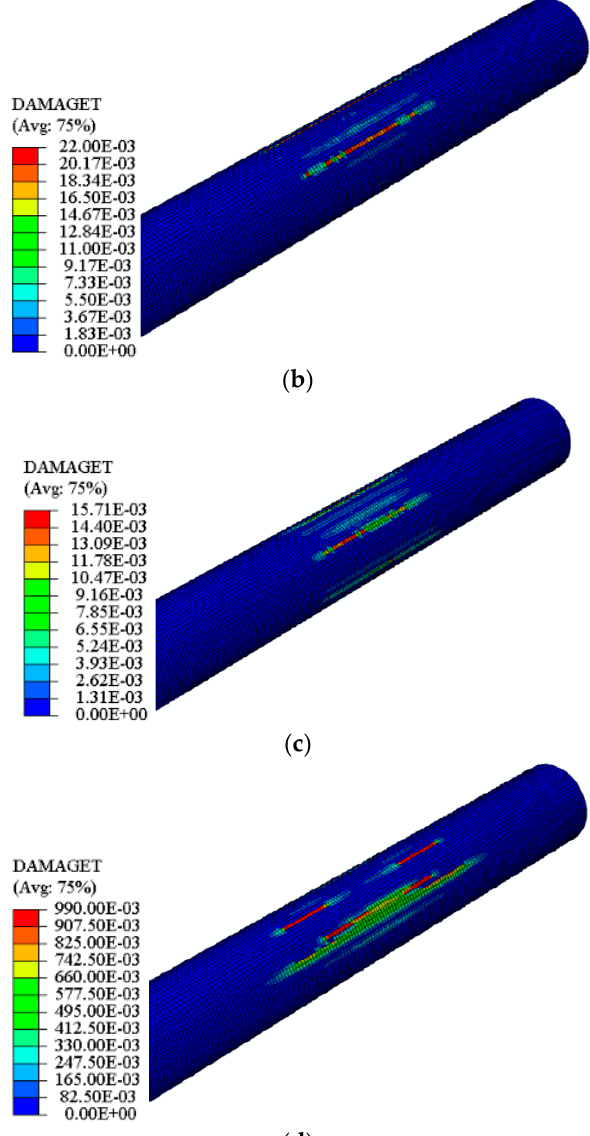
Figure 10. Tension damage contours of ( a ) Jhingurda, ( b ) Singrauli, ( c ) Jamrani, and ( d ) Kota sandstone tunnel when an impact loading occurs due to a 100 kg missile.